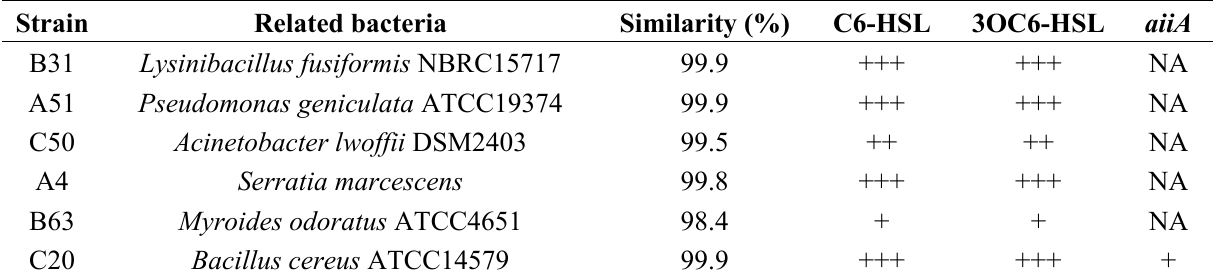
Table 1. Identification and characterization of the representative phyllosphere isolates with lactonase